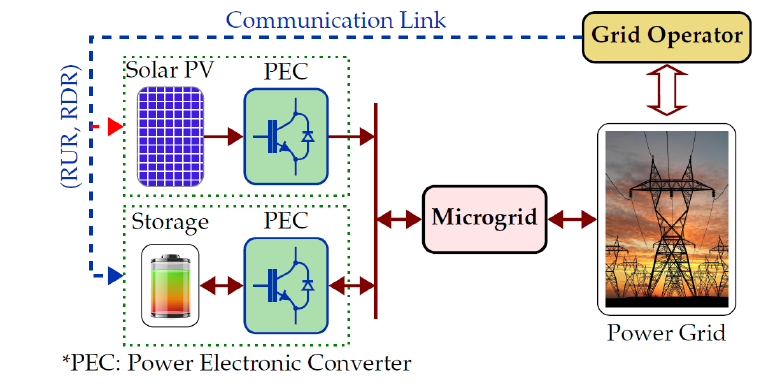
Figure 5. Structure of proposed PV-battery energy storage